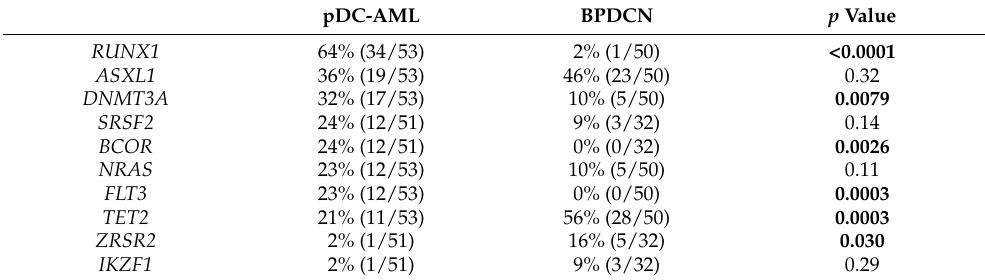
Bold markers and p values indicate a significance difference between these two